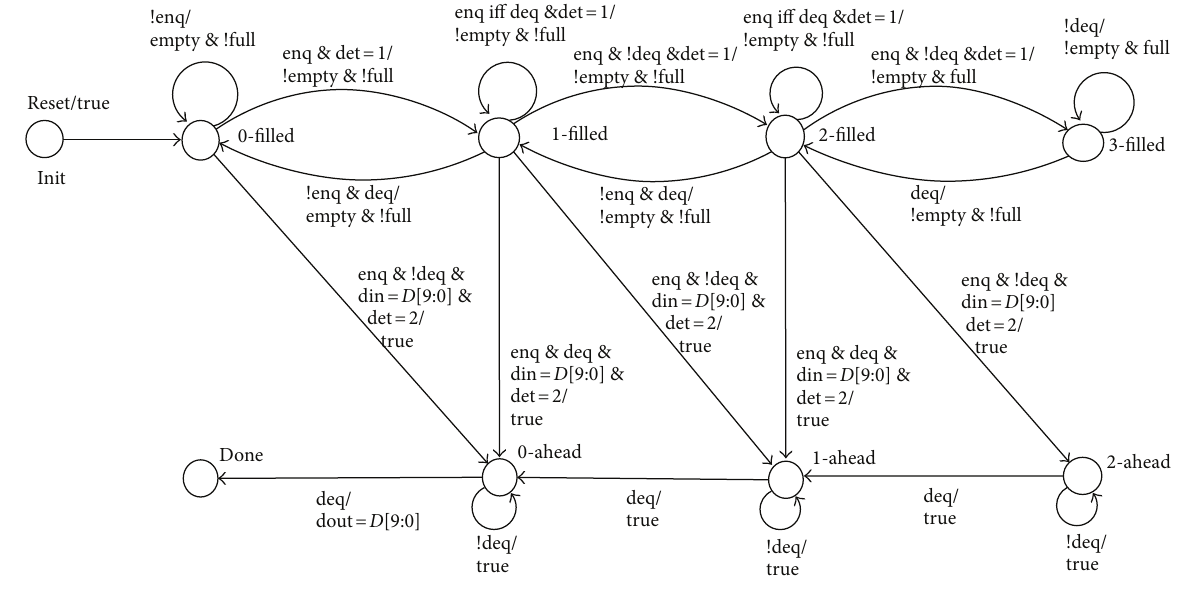
Figure 4: Determinized assertion graph for FIFO.